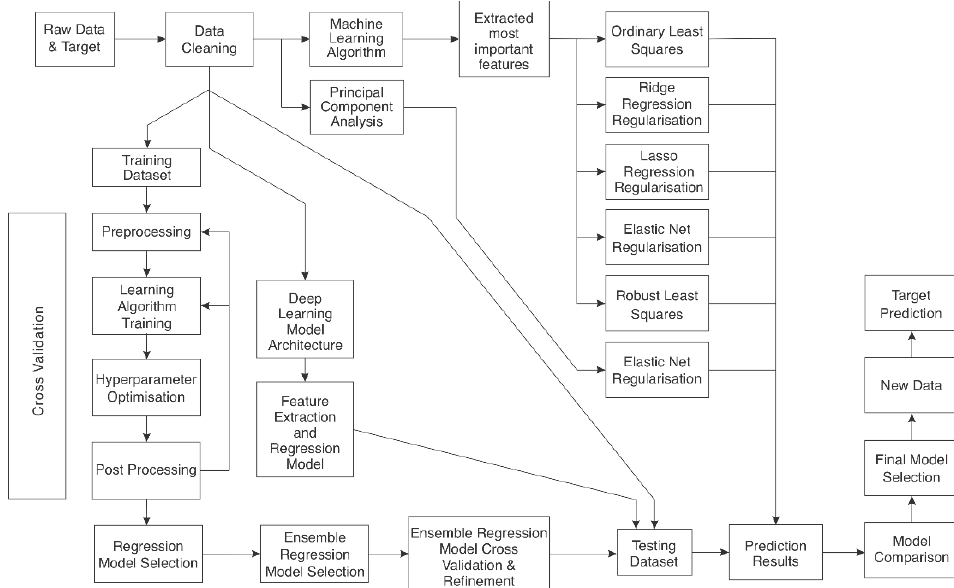
Figure 3. Schematic diagram illustrating the ML workflow.